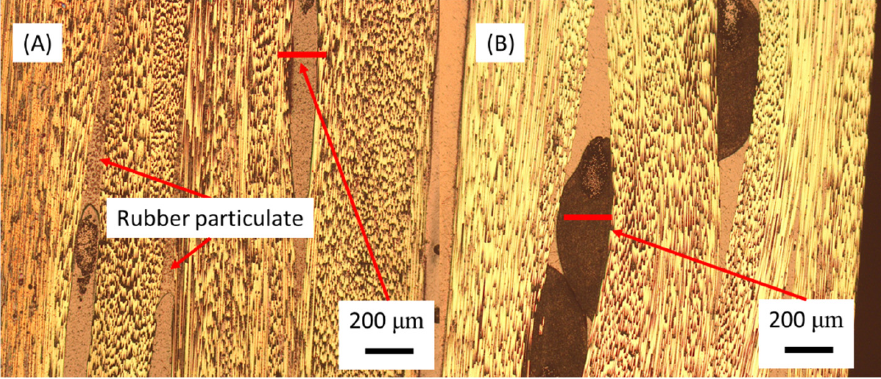
Figure 25. Microscopy of the ( A ) CFRP ‐ R and ( B ) CF samples to determine cross ‐ stitching compression.